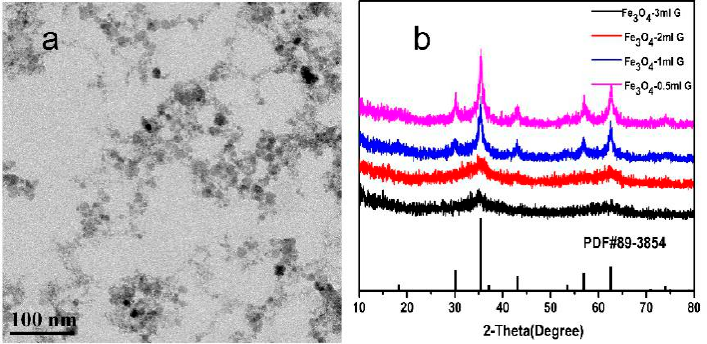
Figure 12. ( a ) TEM image of Fe 3 O 4 nanoparticles prepared by adding 3 mL ginger extract, ( b ) XRD pattern of Fe 3 O 4 nanoparticles prepared by adding different concentrations of ginger extract.